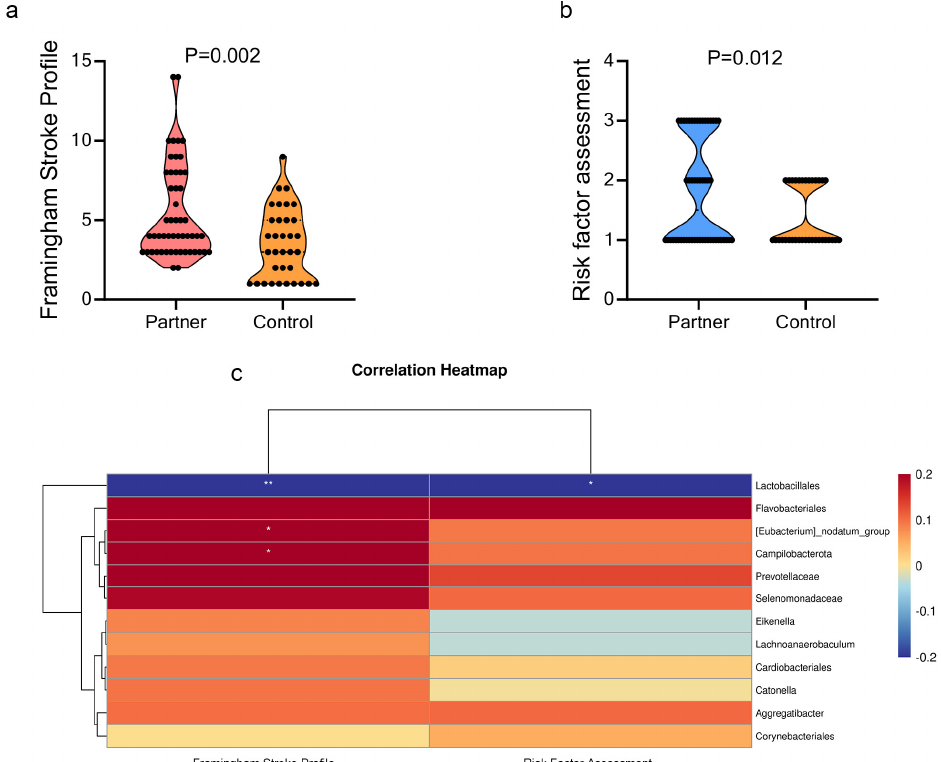
Figure 5. Stroke risk assessment between partners of poststroke patients and controls. ( a , b ) Comparison of Framingham Stroke Profile (FSP) and risk factor assessment (RFA) between the two groups. RFA includes hypertension, diabetes mellitus, dyslipidemia, atrial fibrillation, being overweight, smoking, physical inactivity, and family history of stroke. The FSP uses a Cox proportional hazards model with risk factors as covariates and points calculated according to the weight of the model coefficients (Supplementary Table S1). ( c ) The association between oral microbiota and stroke risk. Heatmap of the Spearman’s correlation between discriminatory bacteria and stroke risk. Red squares indicate positive correlations, whereas blue squares indicate negative correlations. Lactobacillales was negatively associated with FSP. Prevotellaceae was negatively associated with RFA. Campilobacterota and [Eubacterium]_nodatum _group were positively associated with FSP. * p < 0.05, ** p < 0.01.